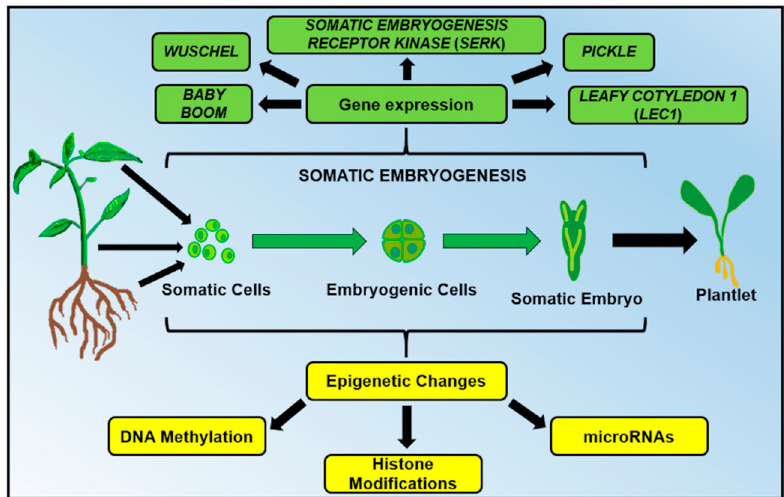
Figure 1. In plant somatic embryogenesis, genetic (green) and epigenetic (yellow) mechanisms induce the development of embryogenic cells from any explant (cells isolated from the leaves, shoots or roots). Due to the totipotentiality properties of plant cells, a group of embryogenic cells can develop into a complete and functional plantlet.